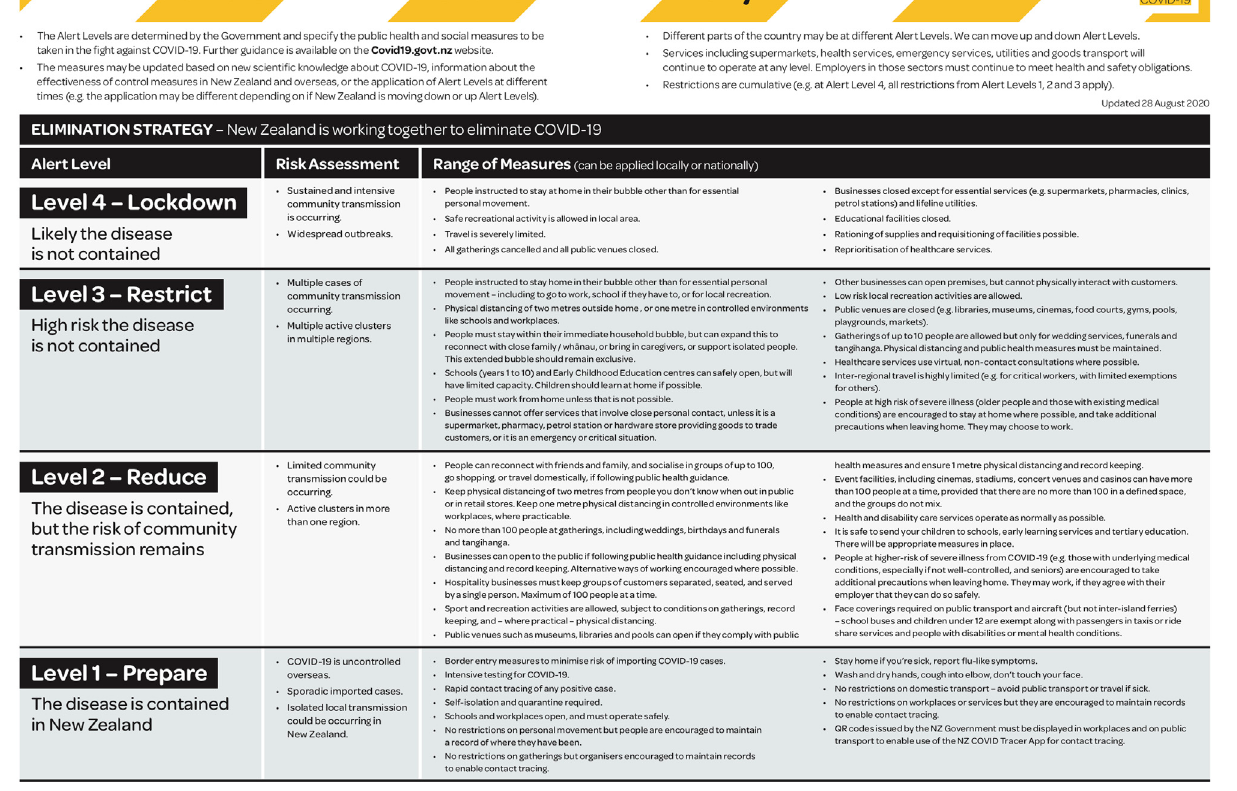
Frontiers in Sociology |